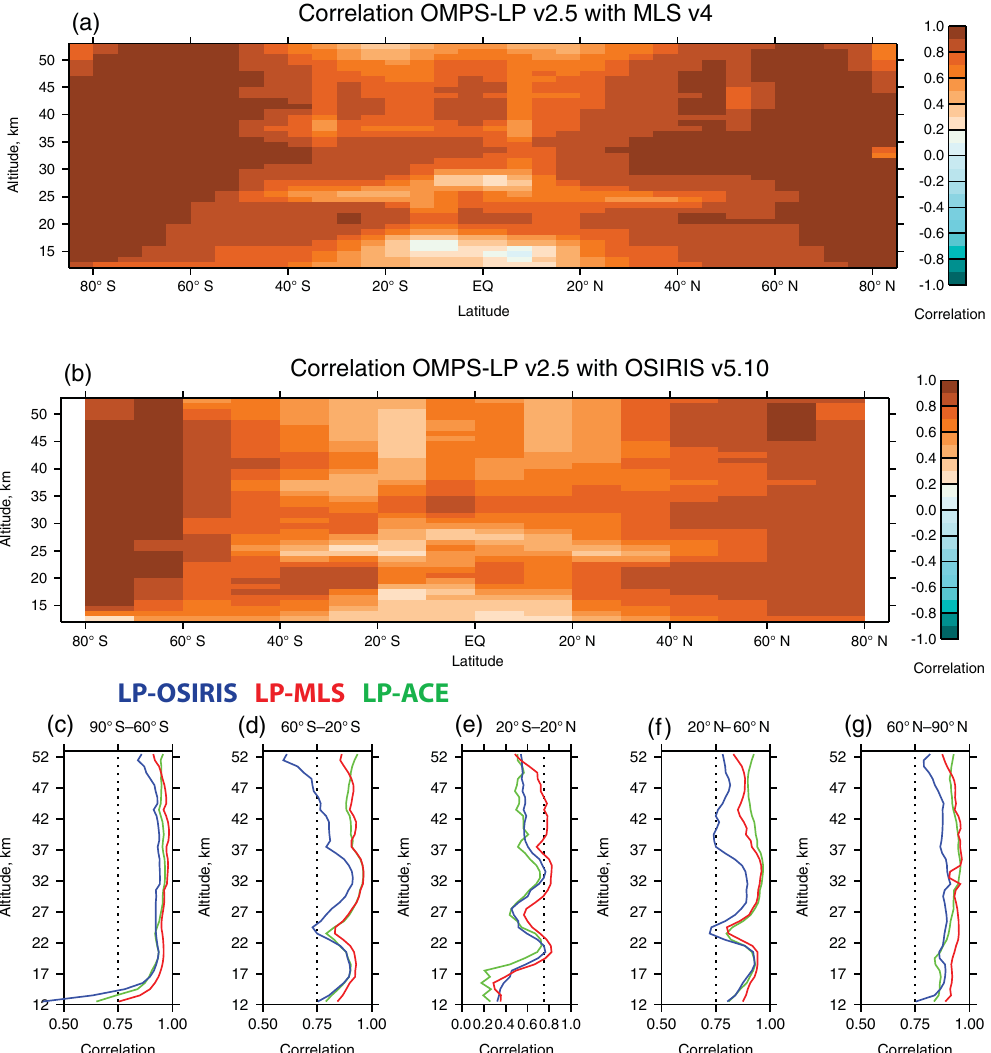
Figure 11. Correlation coefficients between OMPS LP version 2.5 ozone profiles and correlative satellite measurements. Panel (a) shows the correlation between OMPS LP v2.5 and Aura MLS as a function of latitude and altitude (on 5 ◦ latitude grid). Panel (b) shows the correlation between LP and OSIRIS (on 10 ◦ latitude grid). Panels (c–g) show vertical structures of the correlation in five wide latitude